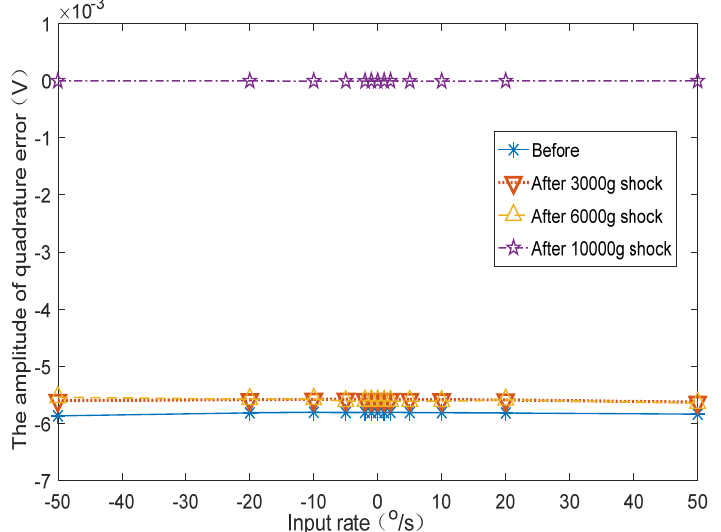
Figure 14. The experimental curves of the quadrature error amplitude before and after the im- pacts. Table 2. The experimental results of scale factor, bias, and quadrature error amplitude before and after the impacts.